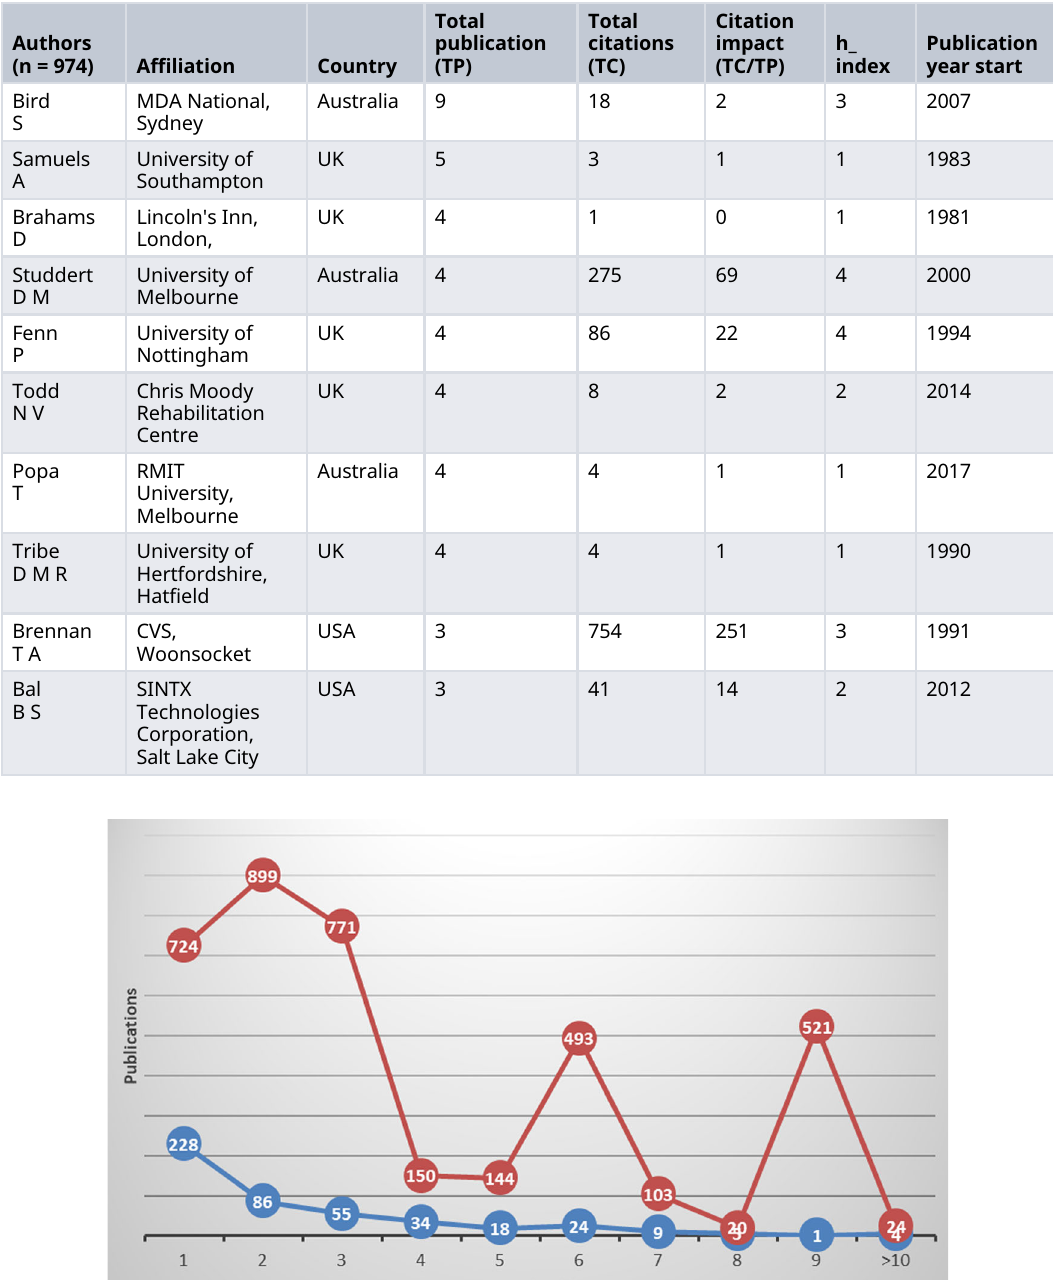
Table 3. Top ten contributing authors and their impact